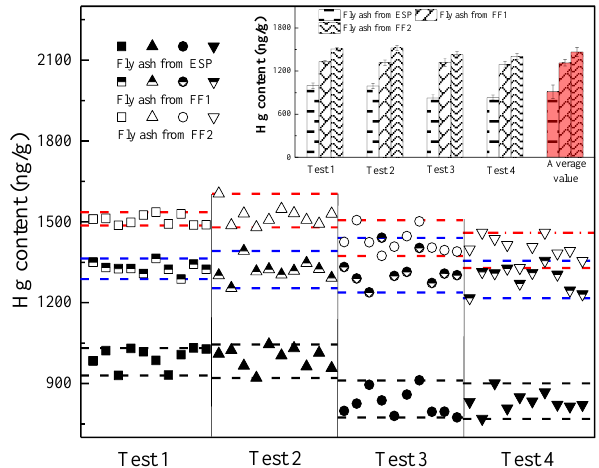
Figure 8. Hg contents in the fly ash samples collected from the ESP, FF1 and FF2.